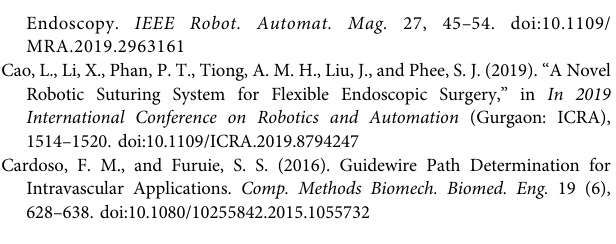
Frontiers in Robotics and AI |